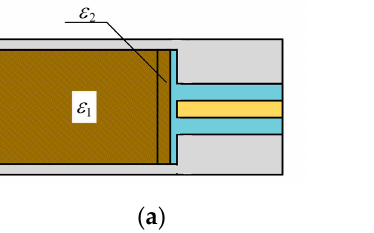
Figure 19. The simulation model for verification effect of the isolation layer: ( a ), with the isolation layer; ( b ), without the isolation layer.